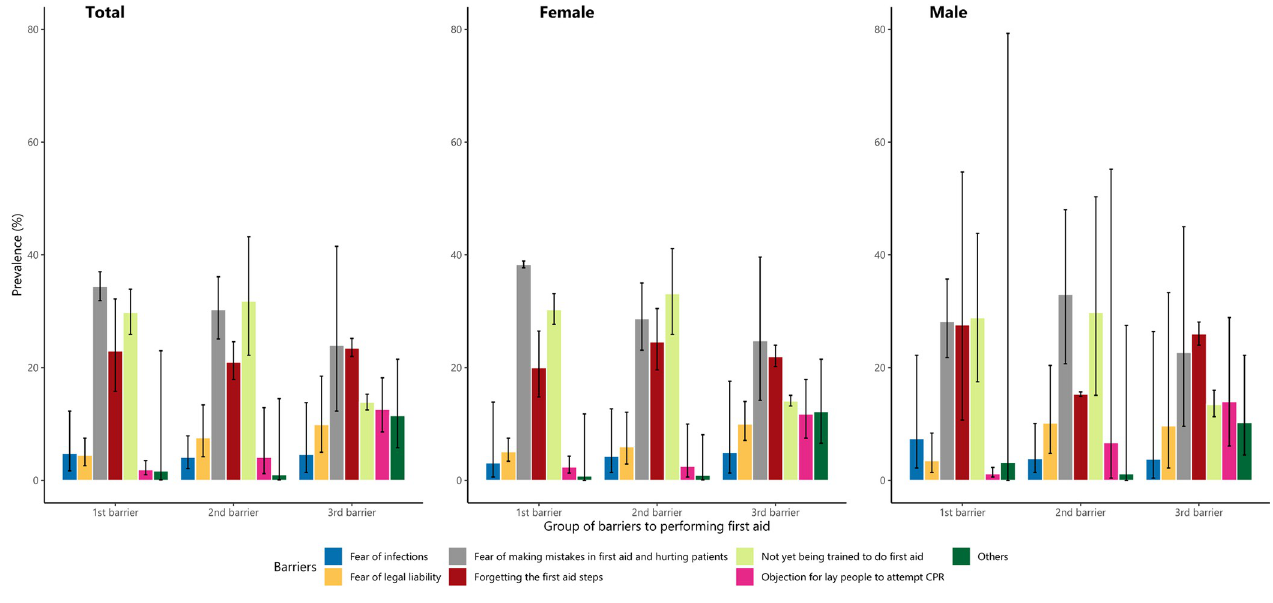
Fig 3. The barriers associated with the students’ willingness to perform first aid.